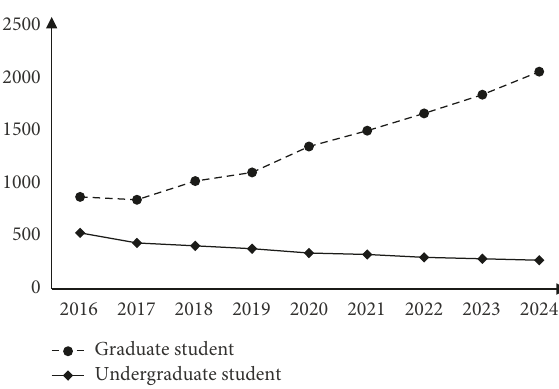
Figure 2: The employment trend of Harbin Engineering University in the aerospace and other defense-related industry.